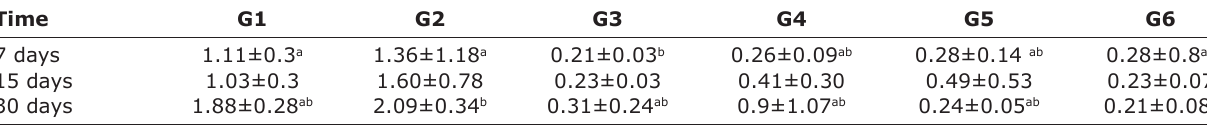
Table-3: Plasma testosterone (ng/mL) of Wistar rats treated with intratesticular injection of zinc gluconate and evaluated at 7, 15, and 30 days after treatment. G1 (saline), G2 (DMSO), G3 (zinc+dipyrone), G4 (zinc+celecoxib+dipyrone), G5 (zinc+meloxicam+dipyrone), and G6